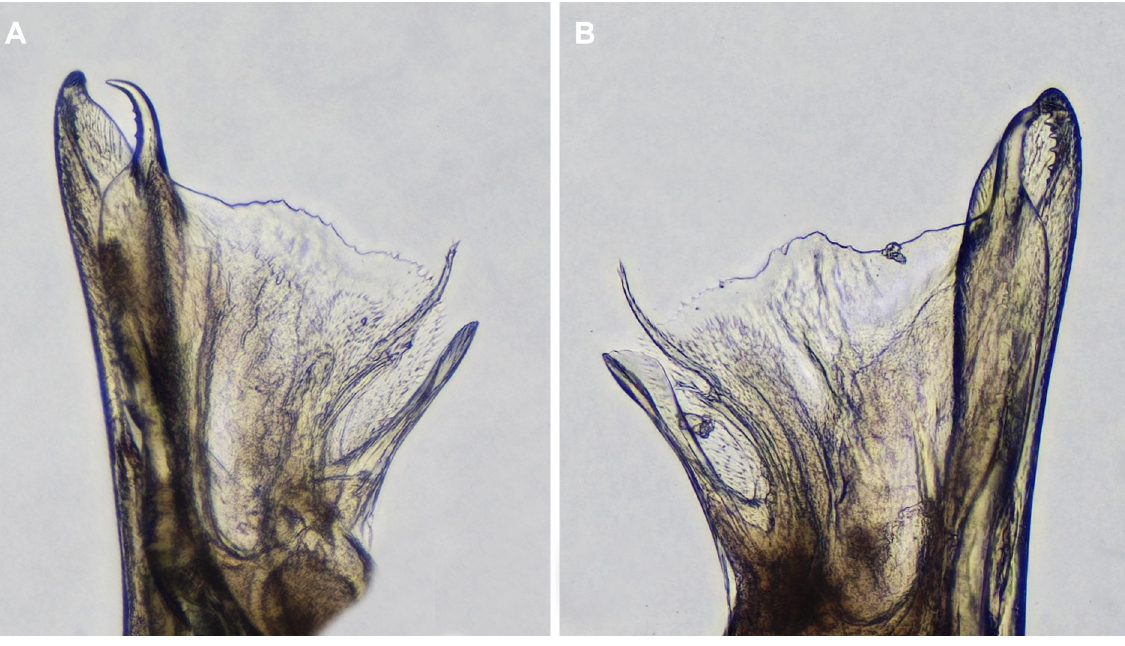
Fig. 20. Leucogeorgia gioi sp. nov., gonopods, lateral views (IZISU). A . ♂ from Kotias Cave. B . ♂ from Shvilobisa